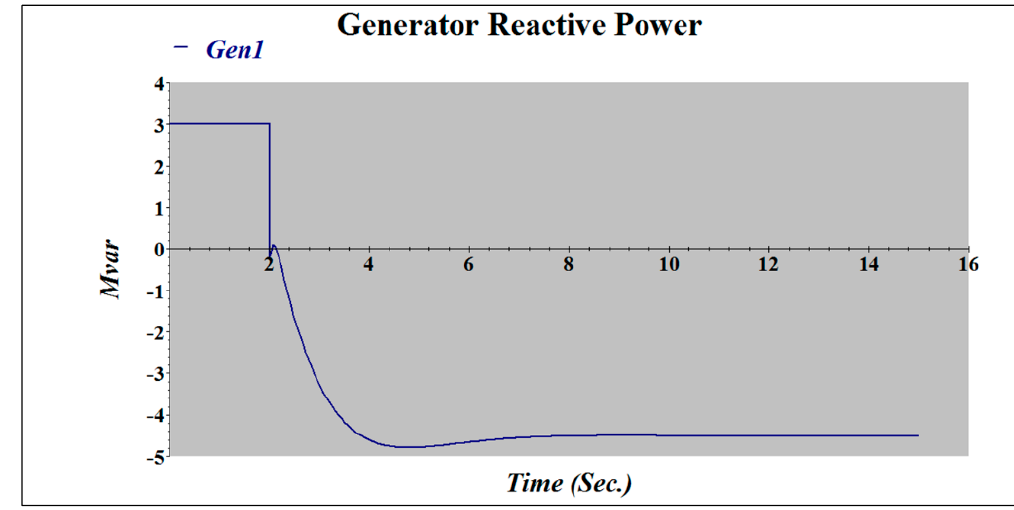
Figure 13. Without UEL at − 10% impact in grind.